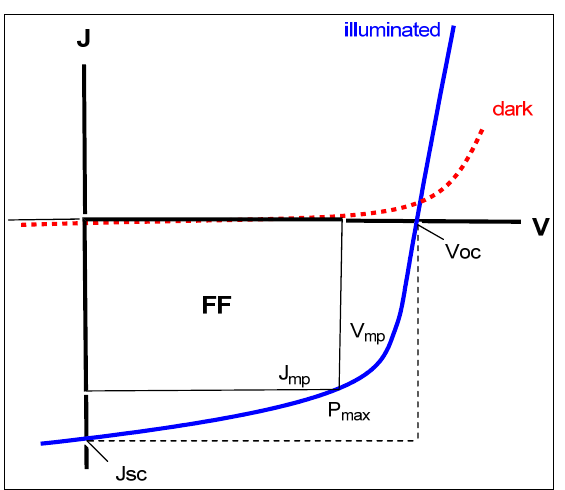
Figure 13. Common current-density–voltage ( J – V ) curve under dark and illumination for a typical organic solar cell.